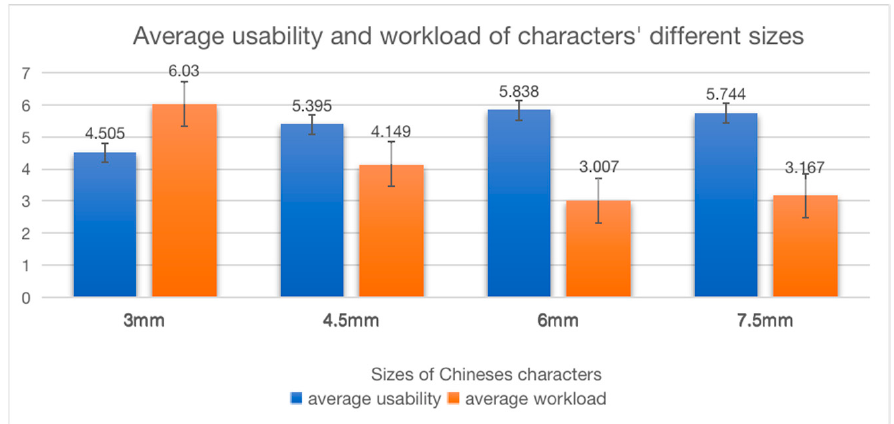
Figure 7. Average usability and workload of Chinese characters’ sizes.